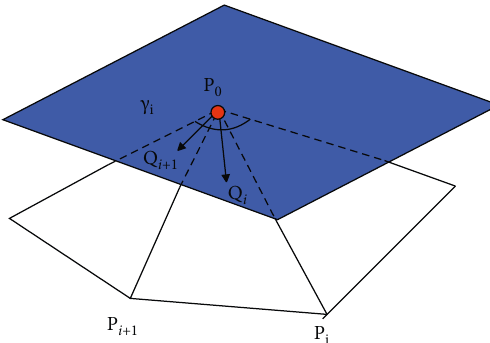
Figure 9: The tangent plane at the vertex and its nearby control